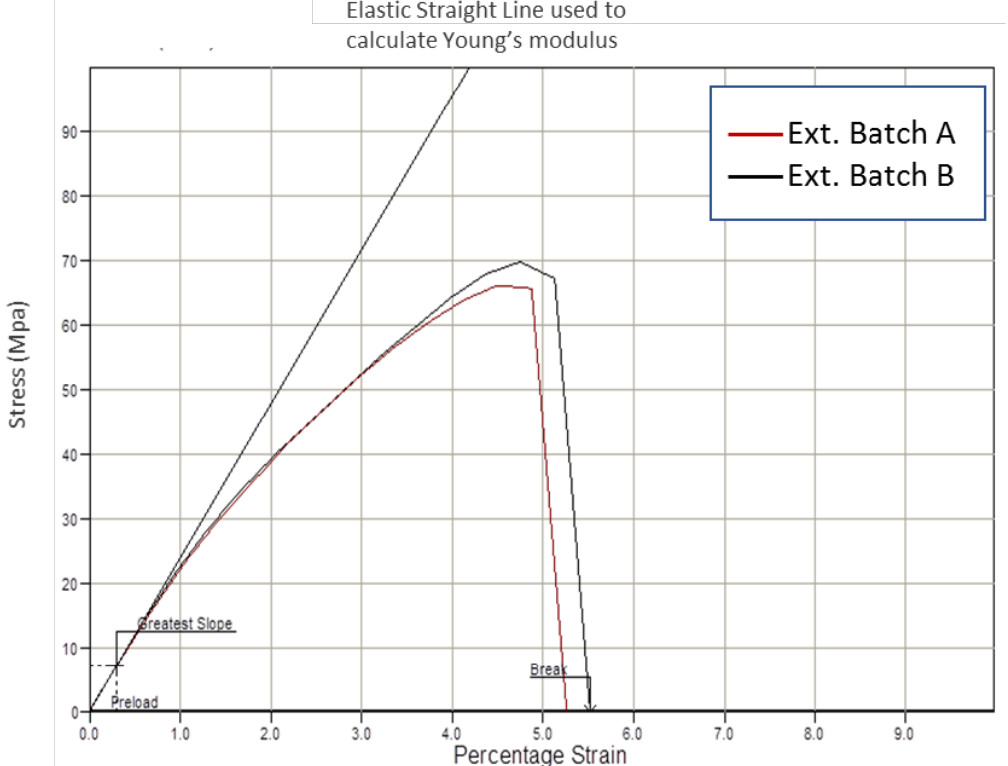
Figure 9. Representative tensile stress / strain curve from Batch A and B extruded tubing.